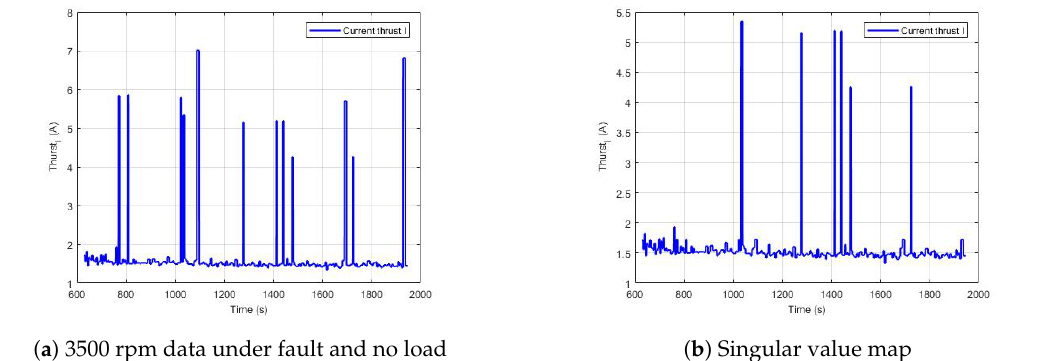
Figure 12. Data for 3500 rpm under fault and no load, and singular value